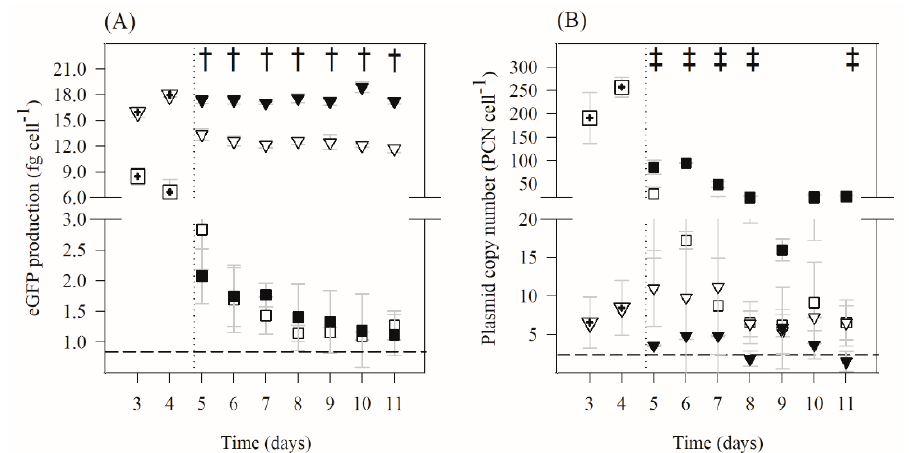
Figure 2. Time-course of ( A ) eGFP production and ( B ) plasmid copy number for planktonic and biofilm cells. Induced ( (cid:72) ) and non-induced ( (cid:53) ) biofilm cells; induced ( (cid:4) ) and non-induced ( (cid:3) ) planktonic cells. The vertical dotted lines indicate the day on which the culture was induced with 2 mM IPTG, and the horizontal dashed lines correspond to detection limits of the methods. The biofilm and planktonic samples corresponding to day 5 were collected 6 h after IPTG addition. Results are an average of three independent experiments for each condition, except in days 3 and 4 that result from an average of six independent experiments (three experiments for induced conditions and three experiments for non-induced conditions; biofilm ( ) and planktonic ( ) cells). The averages ± SDs (indicated as bars) are illustrated. Statistical analysis for a confidence level greater than 95% ( p < 0.05) is pointed as † when induced bio fi lm cells are different from the non-induced bio fi lm cells and as ‡ when induced planktonic cells are different from the non-induced planktonic cells.